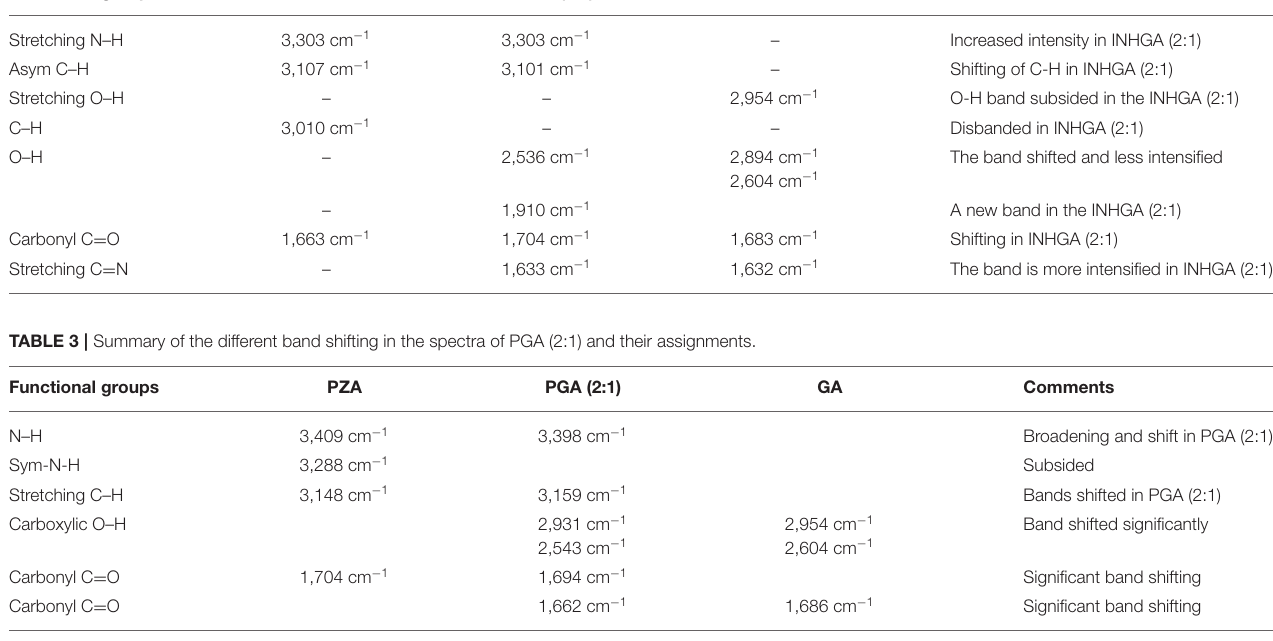
TABLE 2 | Summary of the different band shifting in the spectra of the INHGA (2:1) and their functional groups. Functional groups